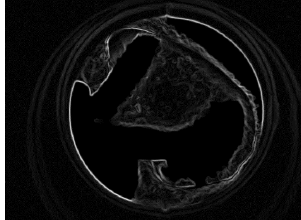
Figure 11. Grayscale VELscope ® image of an oral cavity.